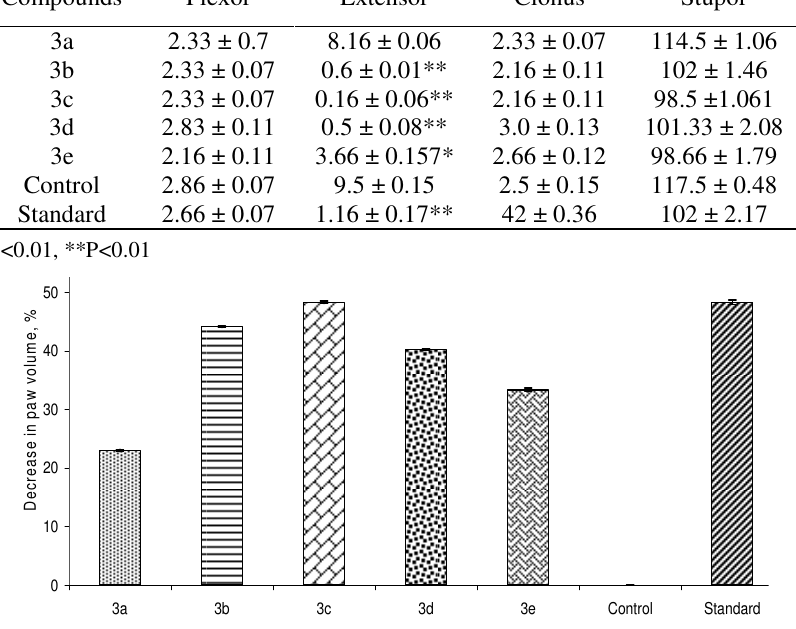
Figure 1 . Anti-inflammatory activity of compounds (3a-e)